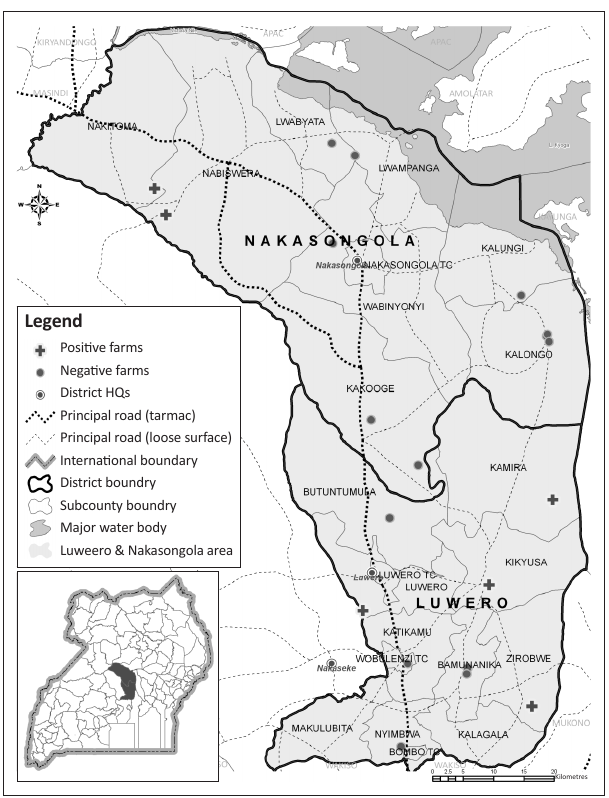
FIGURE 1: Map of Uganda showing two study districts of Luwero and Nakasongola.